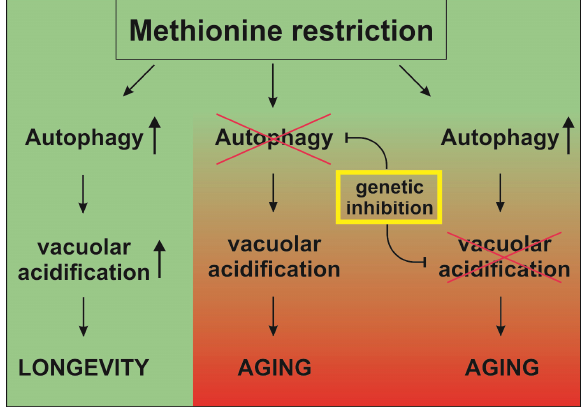
FIGURE 1: Methionine restriction-induced autophagy is causal for longevity-mediating enhancement of vacuolar